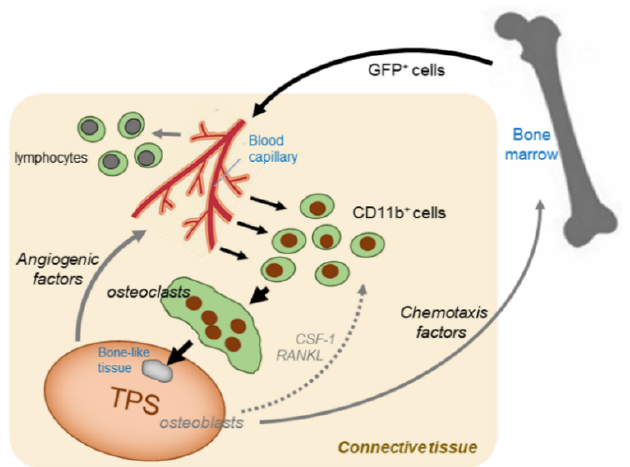
Figure 1. An illustration depicting possible mechanisms of tissue-engineered periosteal sheet (TPS)- induced